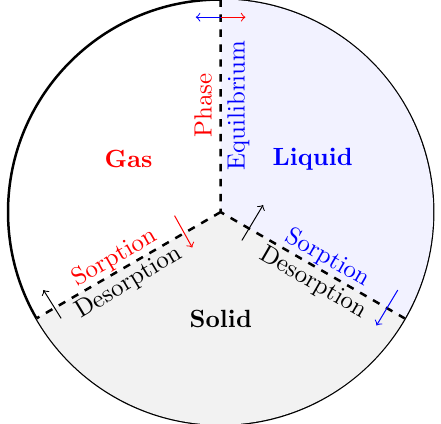
Figure 1. Schematic of the representative elementary volume (REV) conceptualized in the simulations. The volume fraction of liquid and gas phases denotes the porosity while the volume ratio of liquid phase to the porosity is defined as saturation. The mass exchange between gas and solid phases is described by sorption/ desorption and that between gas and liquid phases is described by phase equilibrium.